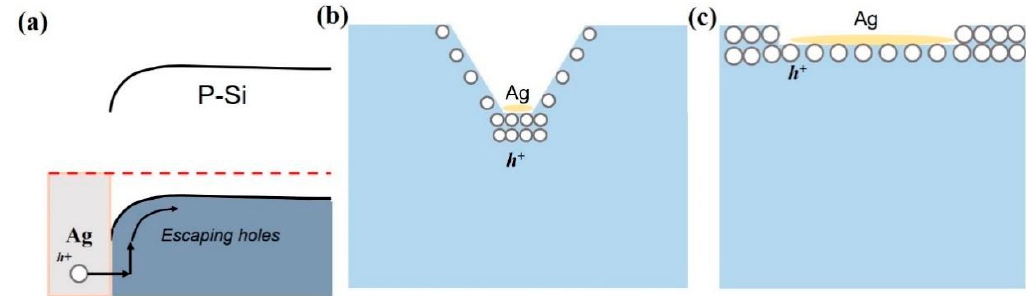
Figure 5. Schematic of Schottky barrier of Ag/Si contact interface ( a ) and transformation of etching behaviors by holes injection difference: ( b ) low H 2 O 2 concentration; ( c ) high H 2 O 2 concentration.